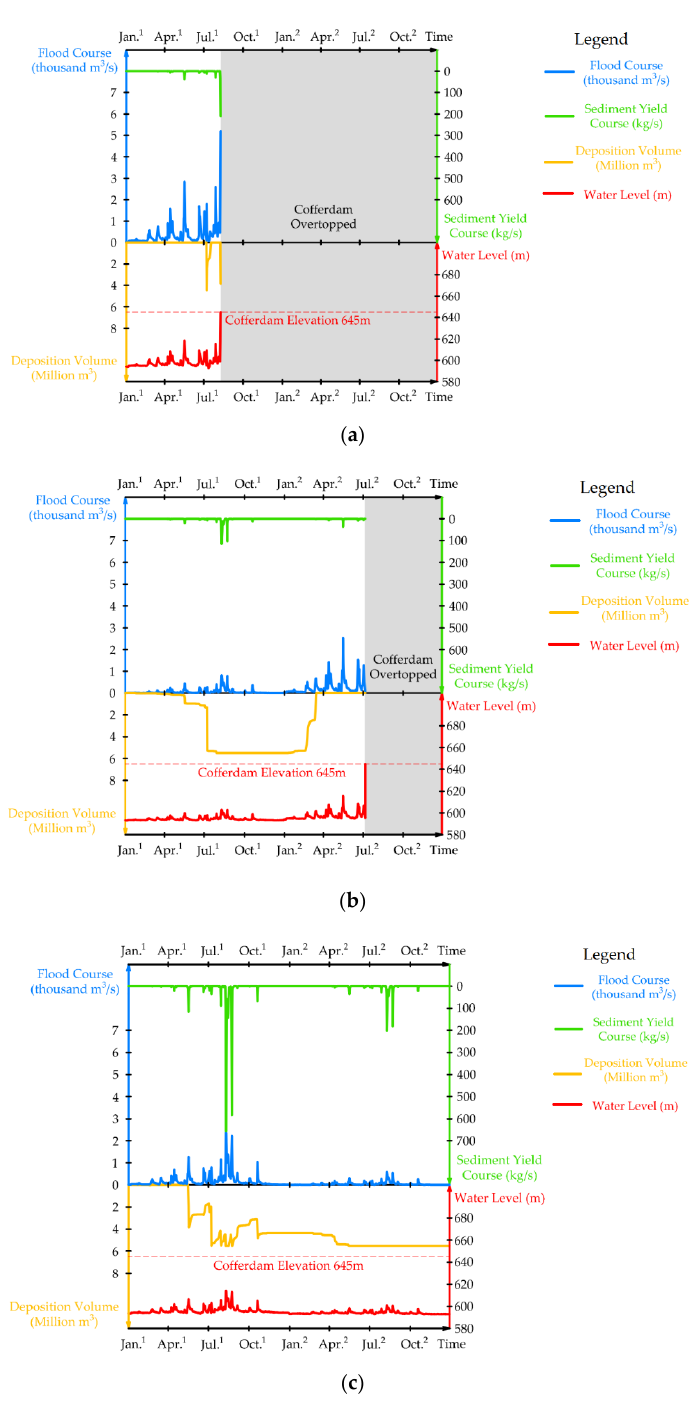
Figure 5. Diversion Risk Conditions (superscript on time denote the diversion year). ( a ) Cofferdam overtopping in the 1st year; ( b ) cofferdam overtopping in the 2nd year; ( c ) safe diversion in all two years.